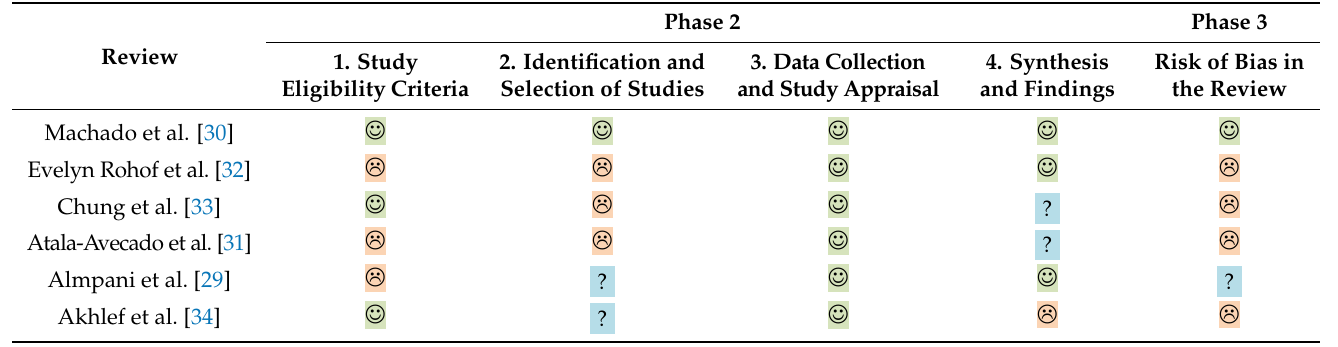
Table 3. ROBIS Results for risk of bias analysis in the included systematic reviews.